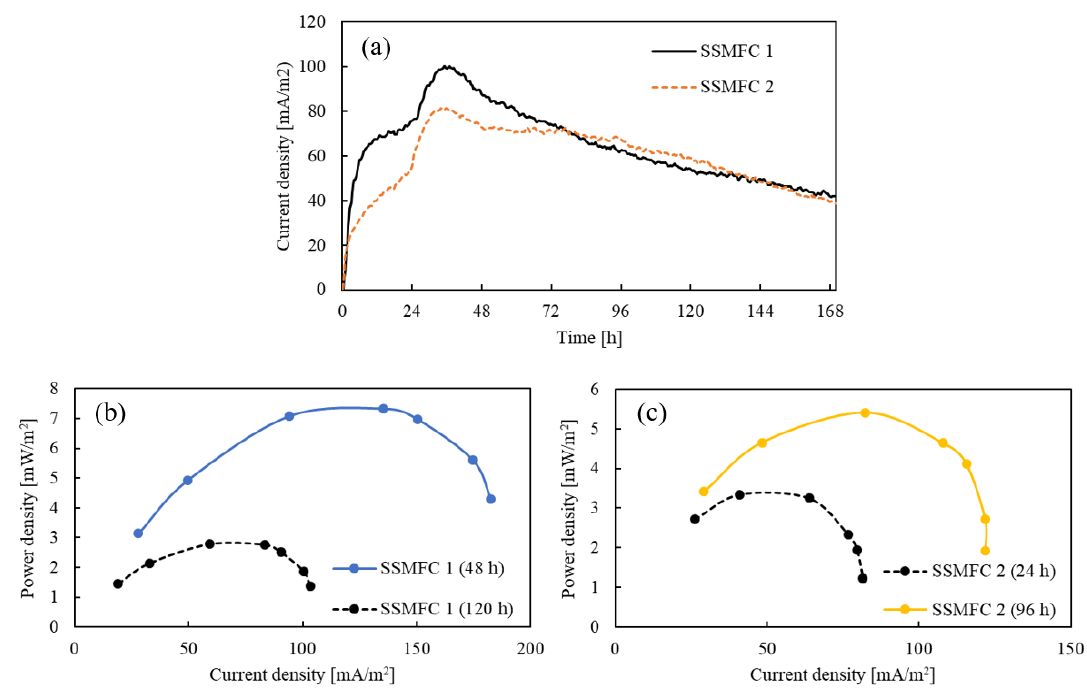
Figure 4. Electricity generation characteristics. ( a ) Polarization curve, ( b ) power density of PSMFC1 measured at 48 h and 120 h, and ( c ) power density of PSMFC2 measured at 24 h and 96 h.